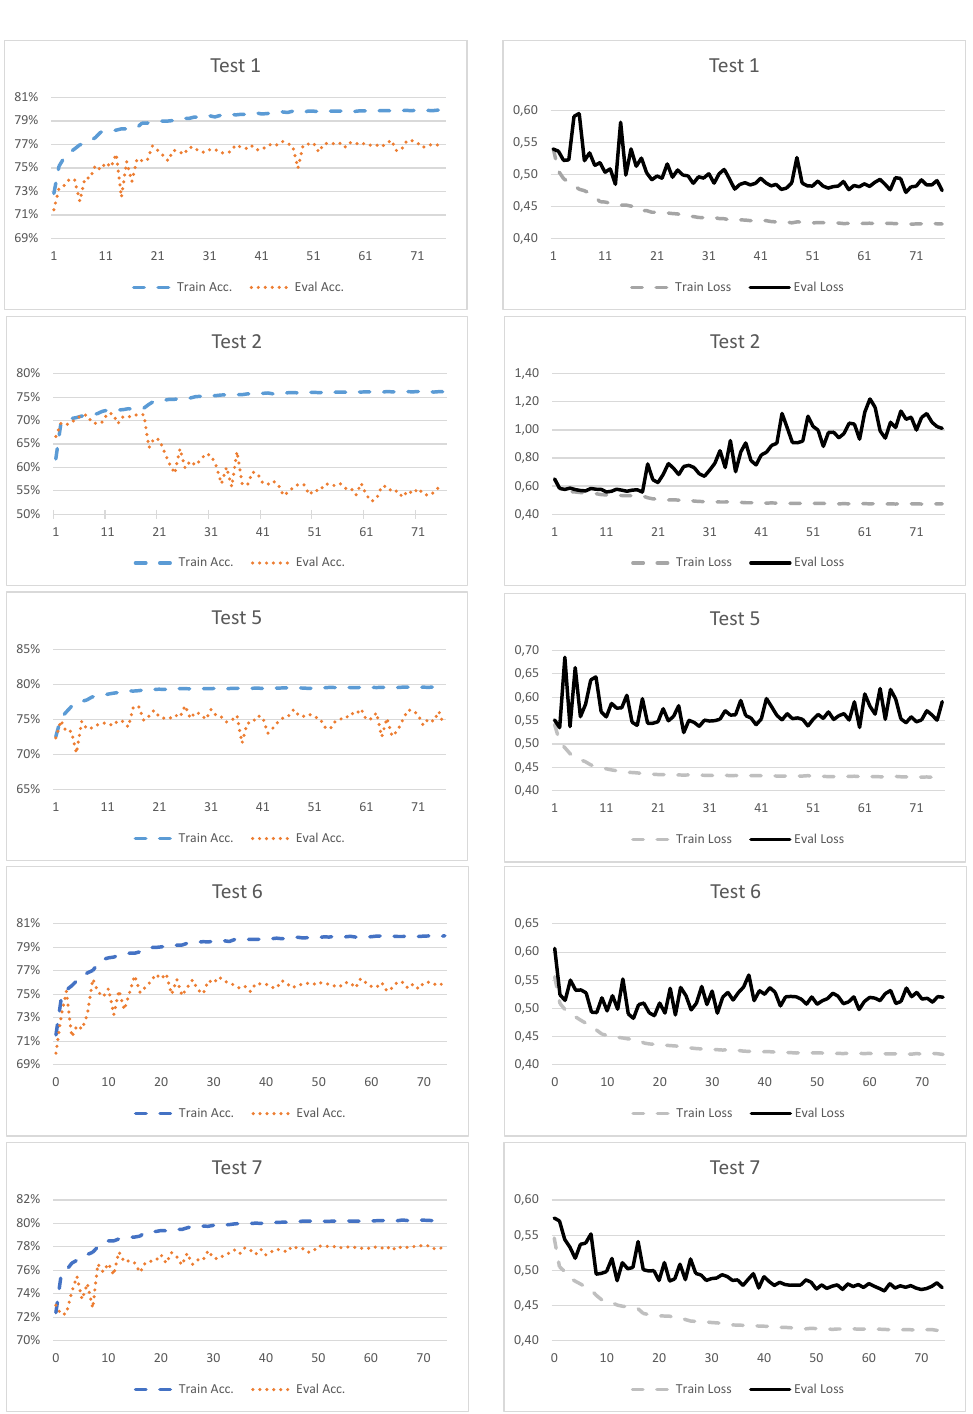
Figure 2: Accuracy and loss for training and evaluation of the urban point cloud with different